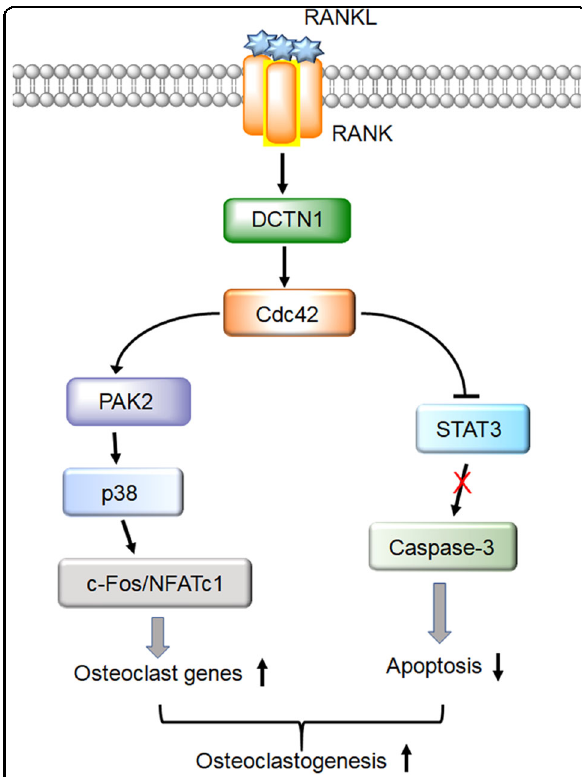
Fig. 8 Schematic model of the proposed mechanism by which DCTN1 regulates osteoclastogenesis. The RANKL-RANK interaction promotes DCTN1-mediated Cdc42 activation. Activated Cdc42 enhances PAK2 phosphorylation, which evokes the transcription of both NFATc1 and c-Fos through the p38 MAPK pathway. DCTN1 also contributes to the survival of OC precursors by suppressing STAT3 activation. A balanced level of DCTN1 is critical for OC differentiation, as both de fi ciencies in and the overexpression of DCTN1 interfere with